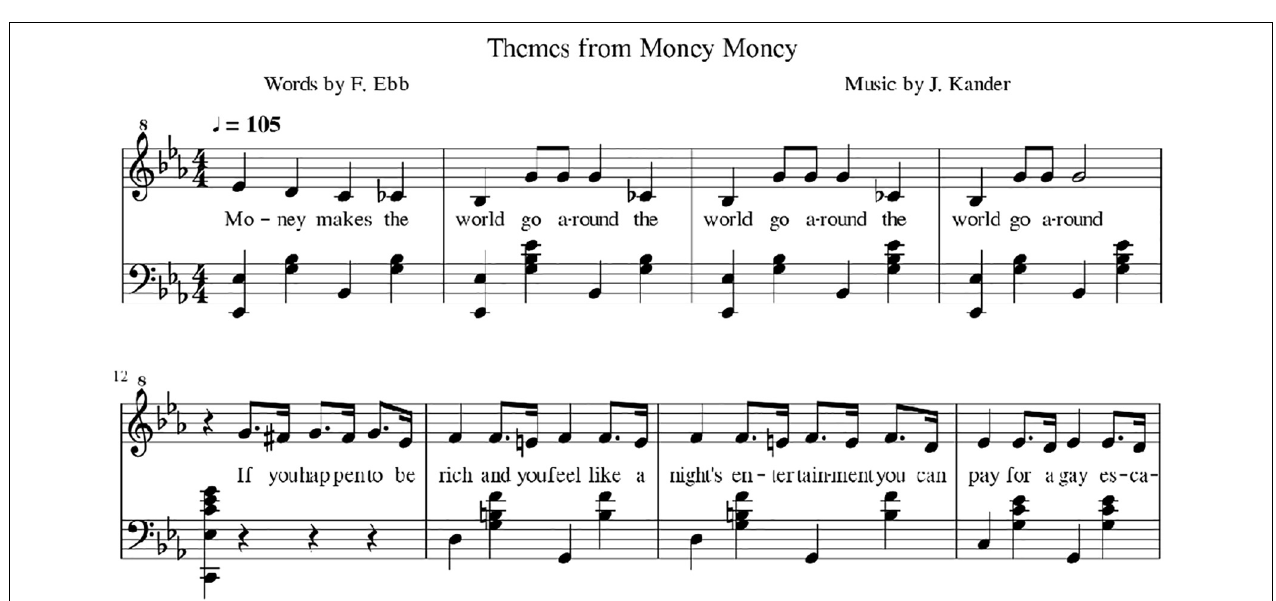
FIGURE 7 | Verse and refrain themes from the song “Money